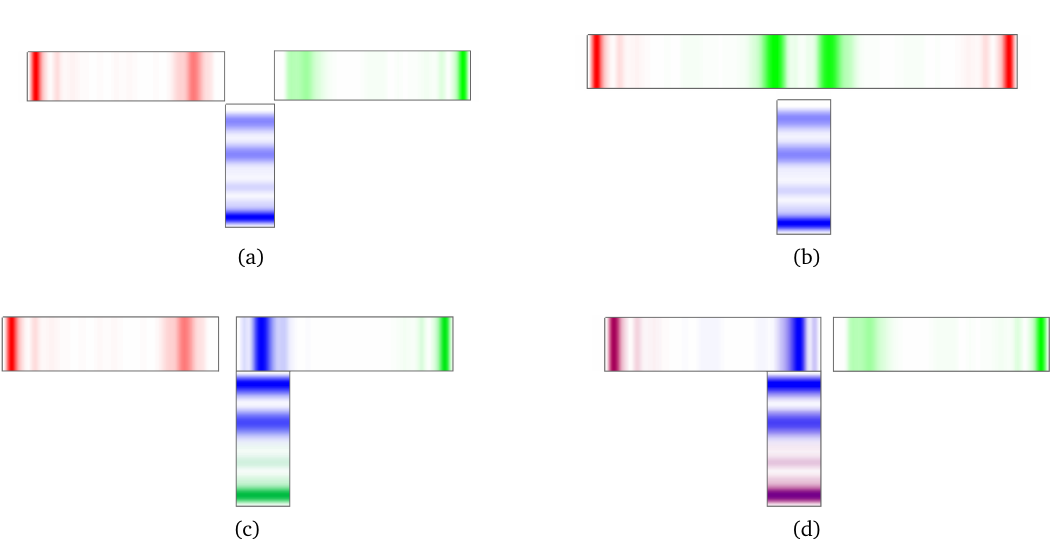
, (b) gate G , (c) gate G activated. Colors 3 1 2